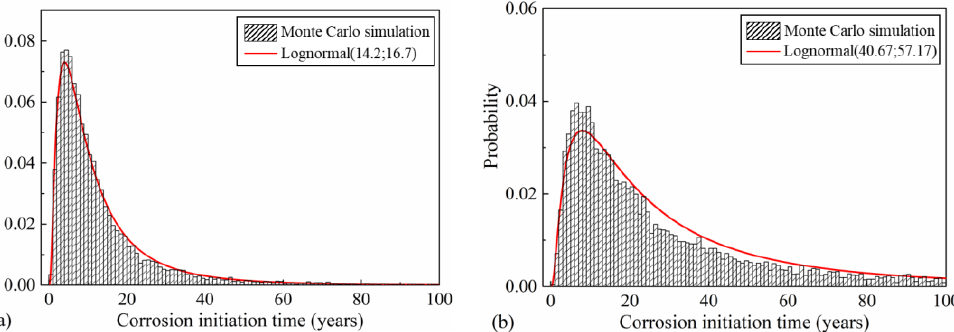
Figure 7. Distribution of corrosion-initiation time: ( a ) splash and tidal zone; ( b ) atmospheric zone. After corrosion initiation, the residual yield strength and cross-sectional area of reinforcement in the pier reduces with the increase in service time, as shown in Figures 8 and 9. In Figure 8, the mean value and standard deviation of the time-variant normalized cross section area (NCSA) are calculated. NCSA is defined as the area of reinforcing steel A ( t ) at time t normalized by the initial area A 0 : NCSA( t ) = A ( t )/ A 0 . This figure illustrates that the cross-sectional area of reinforcing steel more seriously deteriorates in the splash and tidal zone than in the atmospheric zone, according to a comparison of the NCSA in these two zones. For example, the mean NCSA for the atmospheric zone is 0.90 at 60 years. The corresponding value decreases to 0.68 for the splash and tidal region. Figure 8 also depicts that the uncertainty of the NCSA at both corrosion regions increases with service time. This phenomenon can be attributed to the joint effects of the variability of the initial reinforcement area, the corrosion-initiation time, and the corrosion current density. Similar trends are also found for time-variant normalized yield strength (NYS). NYS is defined as the yield strength of reinforcement f y (t) at time t normalized by the initial yield strength f y0 : NYS( t ) = f y (t)/ f y0 . The mean value of NYS, mean plus standard deviation (Mean + Std) of NYS, and mean minus standard deviation (Mean-Std) of NYS are plotted in Figure 9. From Figure 9, it can be found that the NYS more rapidly decreases in the splash and tidal zone than in the atmospheric zone. After 100 years, the mean NYS for the atmospheric zone dropped by 9.2%, with a standard deviation of 8%. The corresponding values for the splash and tidal zone become 25.7% and 11%, respectively.